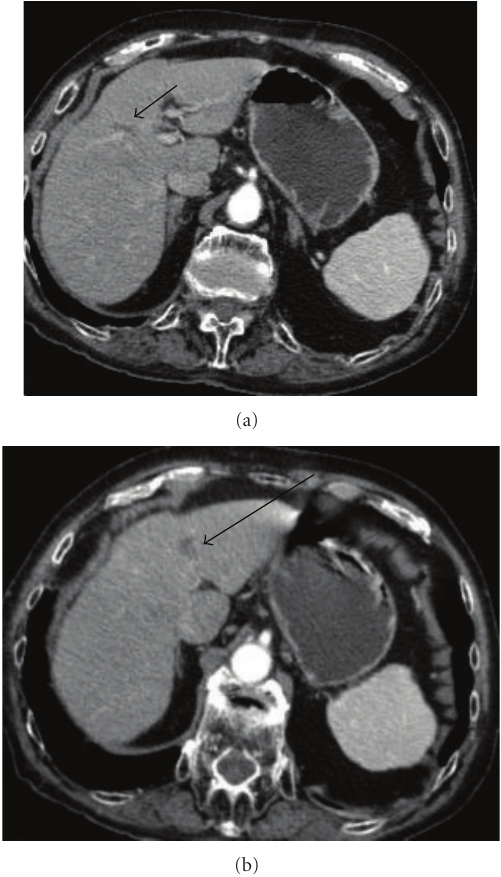
Figure 3: Latest CT scan, 12 years after the initial RF procedure; both lesions (arrows) are hardly visualized and might be misdiag- nosed as cystic formations in the liver.